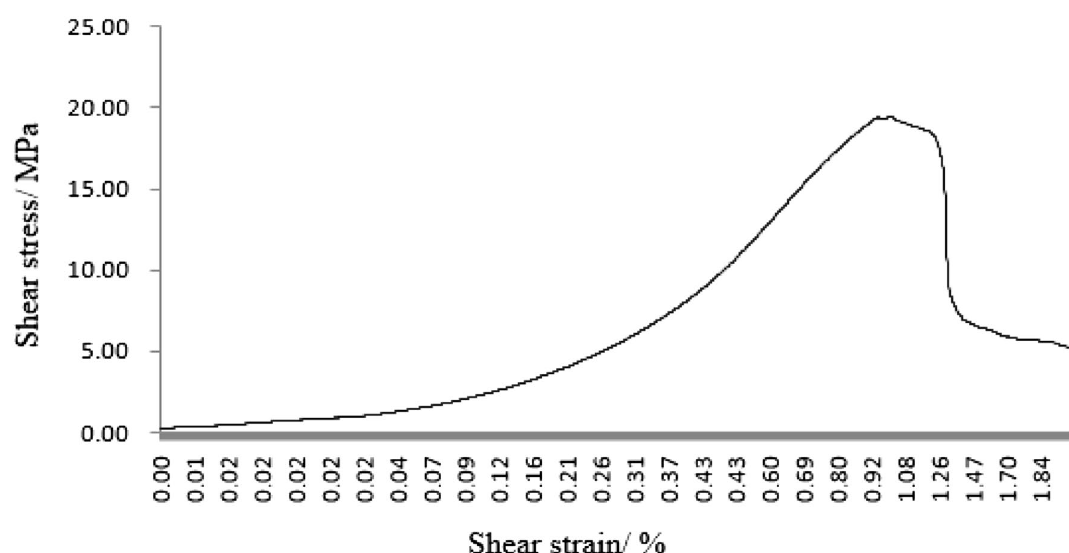
Figure 33. The third fracture mode rock shear stress-shear strain